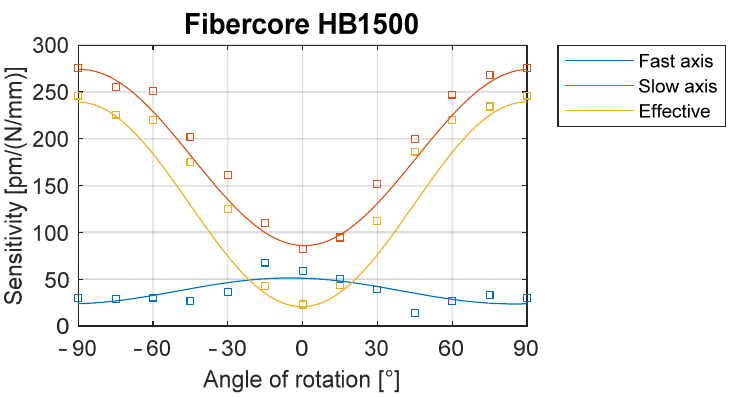
Figure 6. Transverse force sensitivity of the FBG sensor inscribed in the bow-tie (HB1500) fiber vs. angle of rotation.